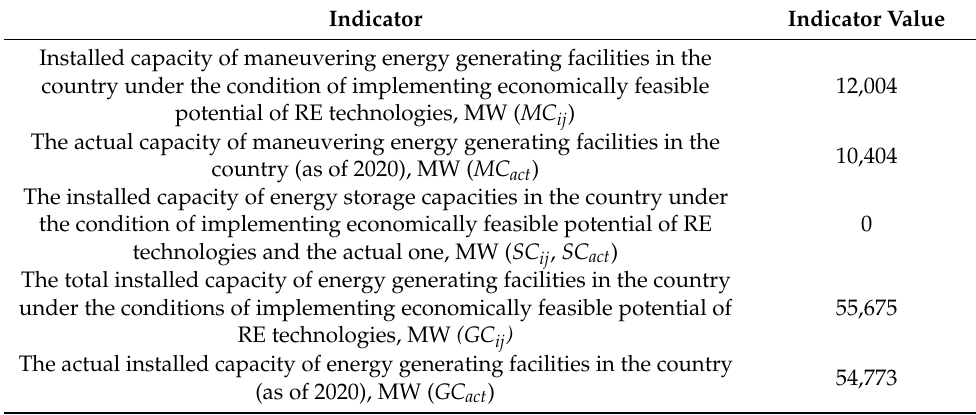
Table 7. Data for calculating c 6 sol Sumy ; c 6 win Sumy